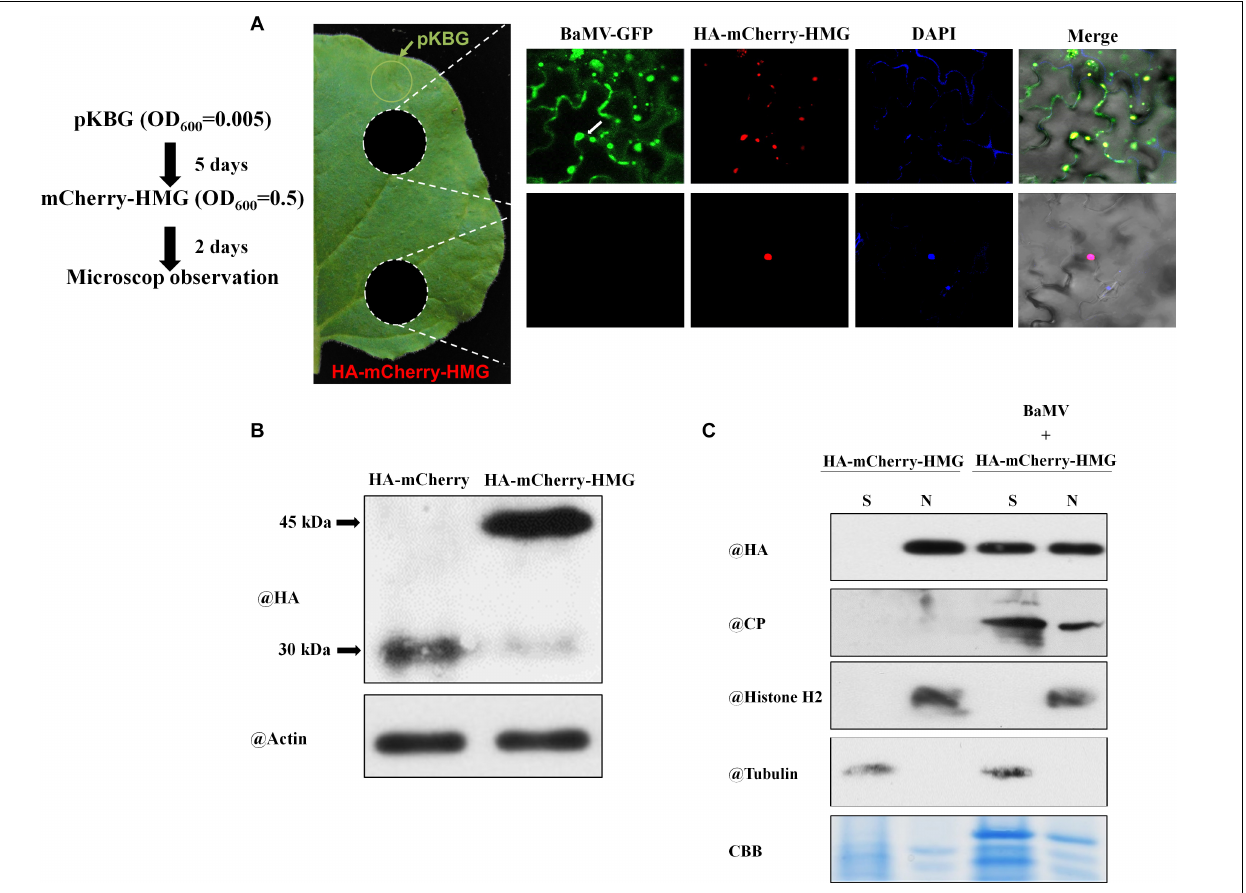
FIGURE 6 | Localization of NbHMG1/2a in BaMV-GFP-infected N. benthamiana . (A) Leaves of N. benthamiana were agroinfiltrated with pKBG (BaMV-GFP) (OD = 0.005) into the region represented by the green circle. Five days later, inoculated leaves were agroinfiltrated with mCherry-HMG (OD = 0.5) in whole leaves. Samples were excised (white circles) 2 days afterward for confocal microscopic observation. To detect the nucleus, 4 (cid:48) ,6-diamidino-2-phenylindole (DAPI) solution was infiltrated into the N. benthamiana leaves before observation. Scale bars are 50 µ m. Arrows and arrowheads indicate nucleus and cytoplasm, respectively. The experiment was repeated three times with similar results, and representative images are shown. (B) Protein gel blot analysis of HA-mCherry and HA-mCherry-HMG at 2 dpi by anti-HA or anti-actin body. (C) Protein gel blot analysis of HA-mCherry-HMG in subcellular fractions of BaMV infected leaf tissues. Histone H2 was used as a nuclear marker, and cytosolic tubulin served as a cytosolic marker. N, nuclear protein extracts; S, total protein extracts depleted of